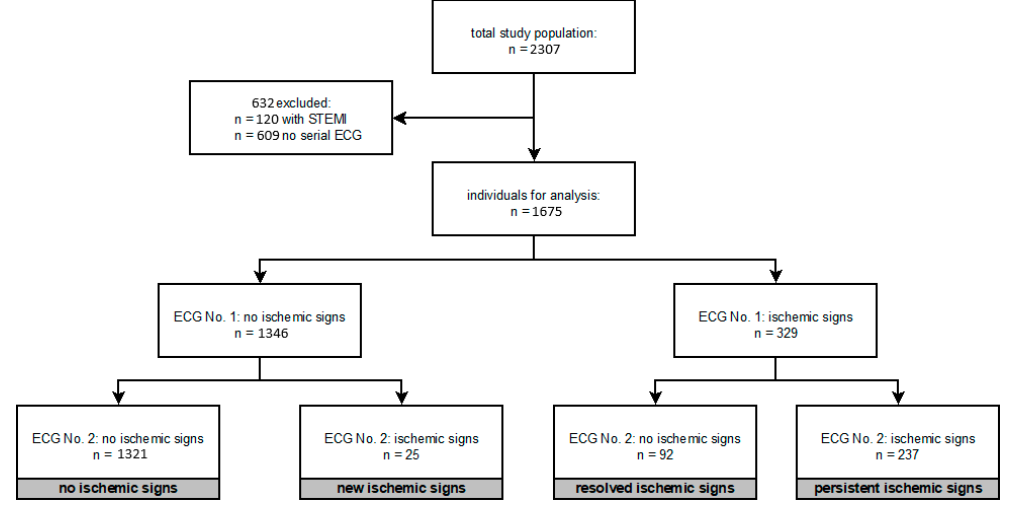
Figure 1. Overview of the study population .